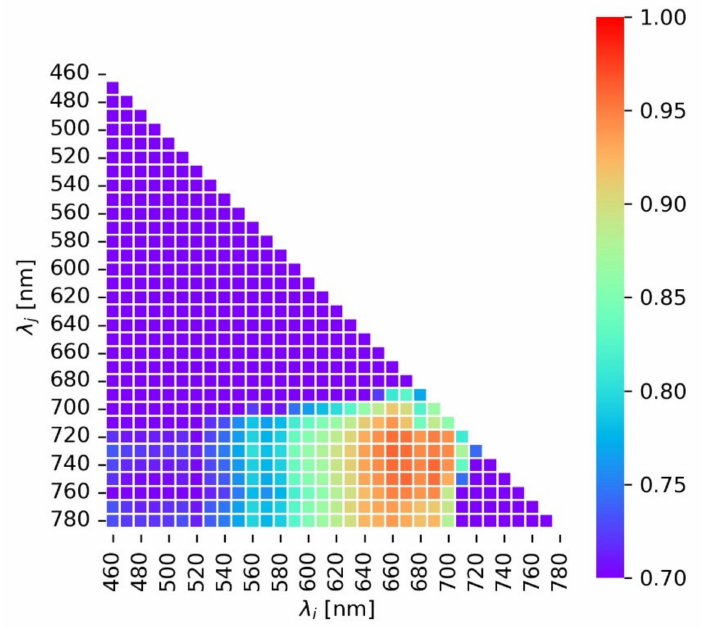
Figure 7. The accuracy assessment results for all the spectral band